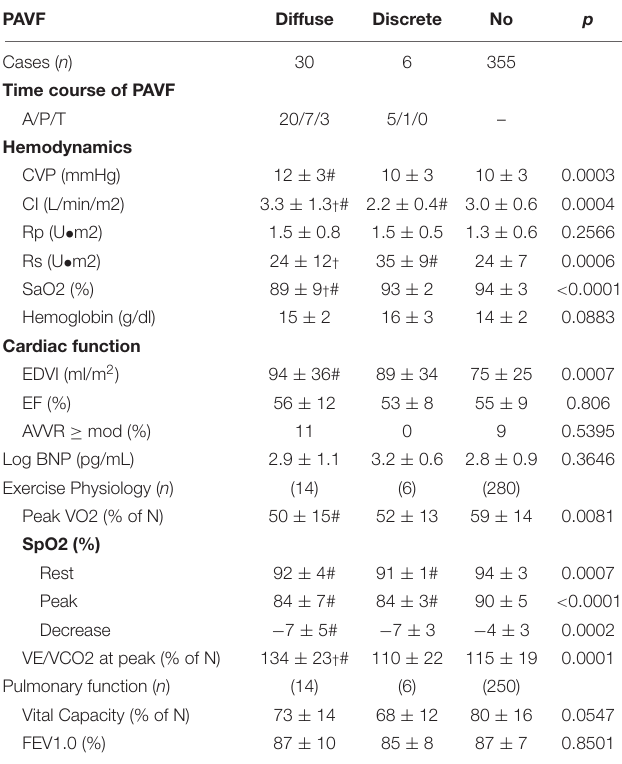
TABLE 2 | Hemodynamics and exercise physiology in PAVF patients at the time of detection. PAVF